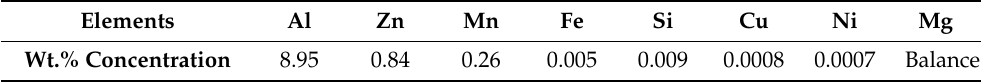
Table 1. Nominal chemical composition of the investigated AZ91 alloy. Elements